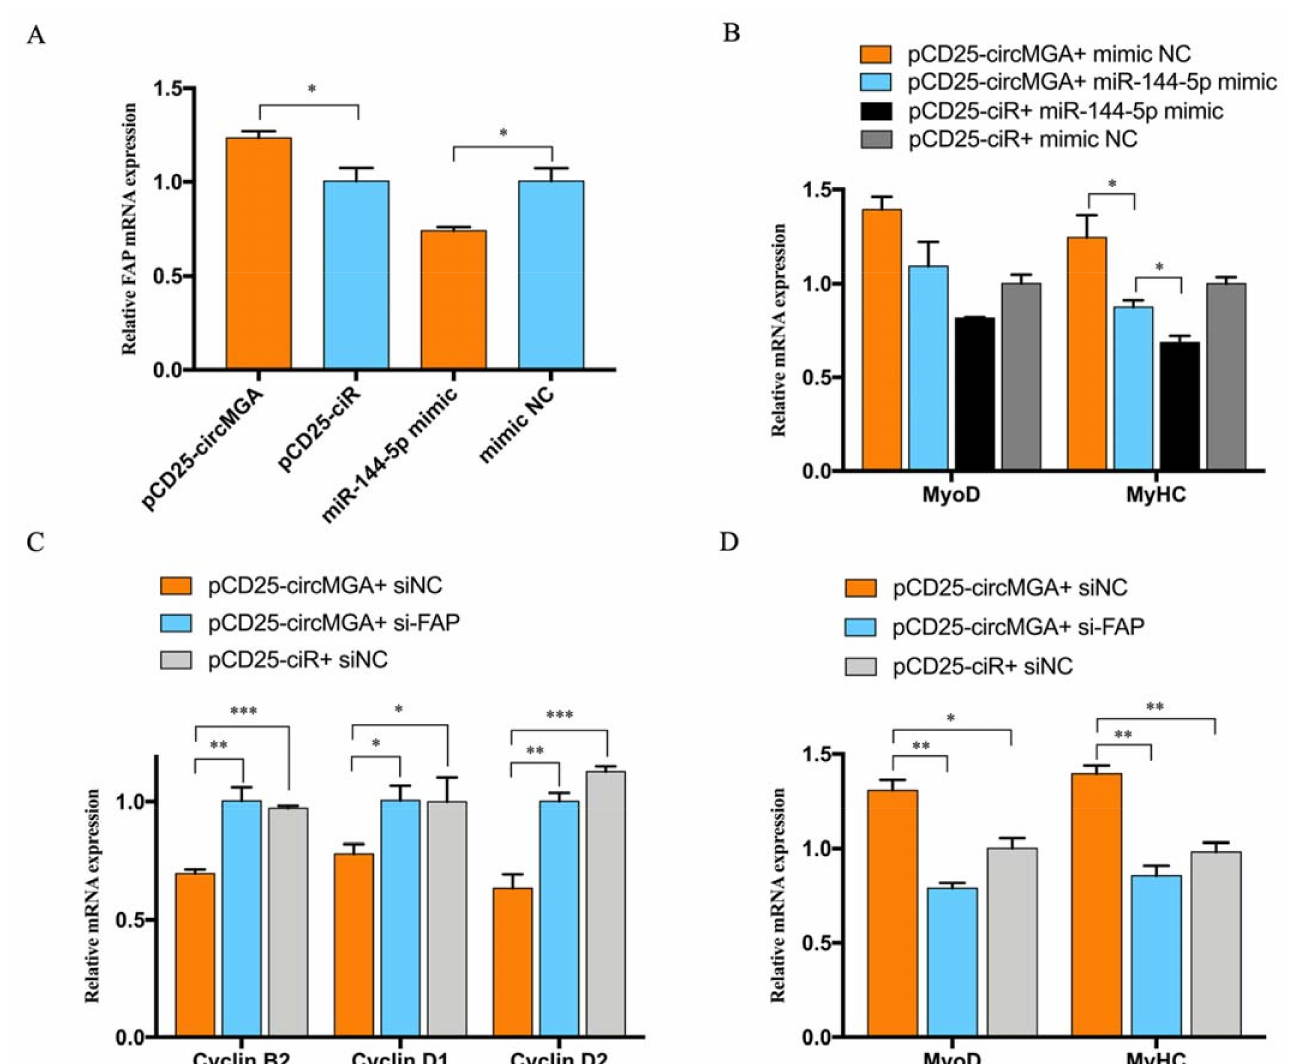
Figure 5. CircMGA promotes myotube formation through miR-144-5p/FAP signal. ( A ) The RNA expression of FAP after circMGA and miR-144-5p overexpression. ( B ) The mRNA expression of MyoD and MyHC after pCD25-circMGA and miR-144-5p co-transfection. ( C ) qRT-PCR results of Cyclin B2, Cyclin D1, and Cyclin D2 after pCD25-circMGA and si-FAP co-transfection. ( D ) Changes of MyoD and MyHC mRNA level after transfected with pCD25-circMGA and si-FAP/NC. (* p < 0.05; ** p < 0.01, *** p <